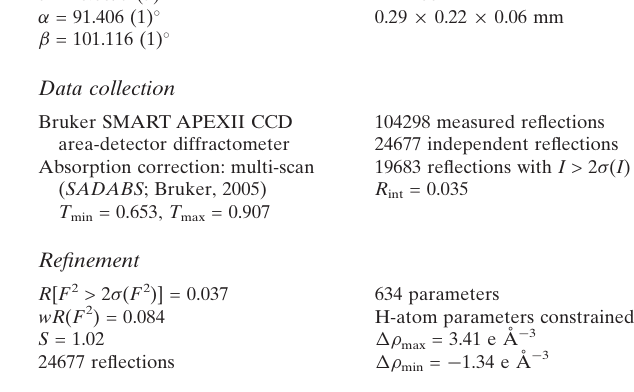
triangulo -triruthenium compound, the bis(diphenylphos-